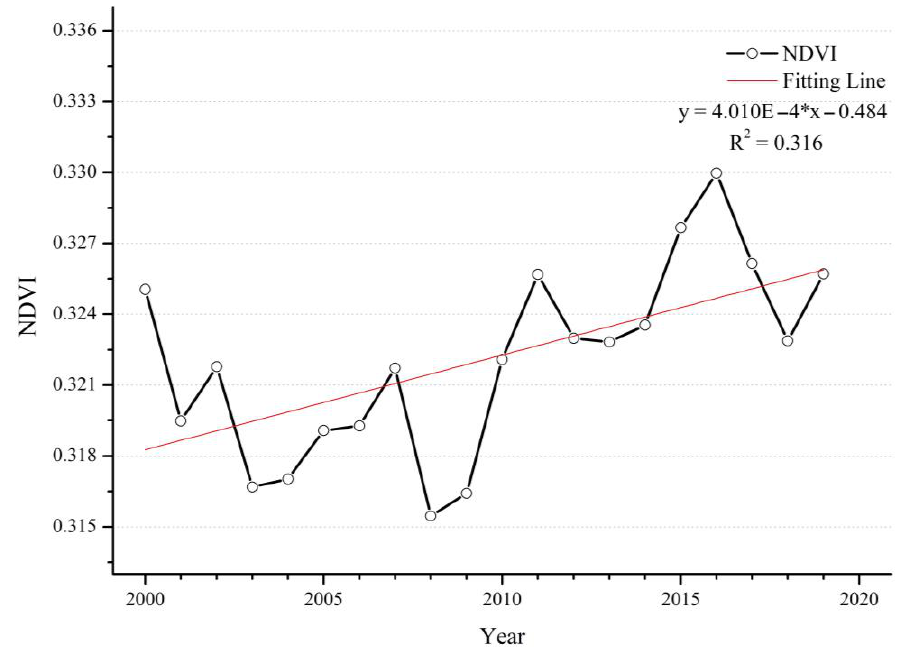
Figure 3. Time series of the annual mean NDVI from 2000 to 2019.